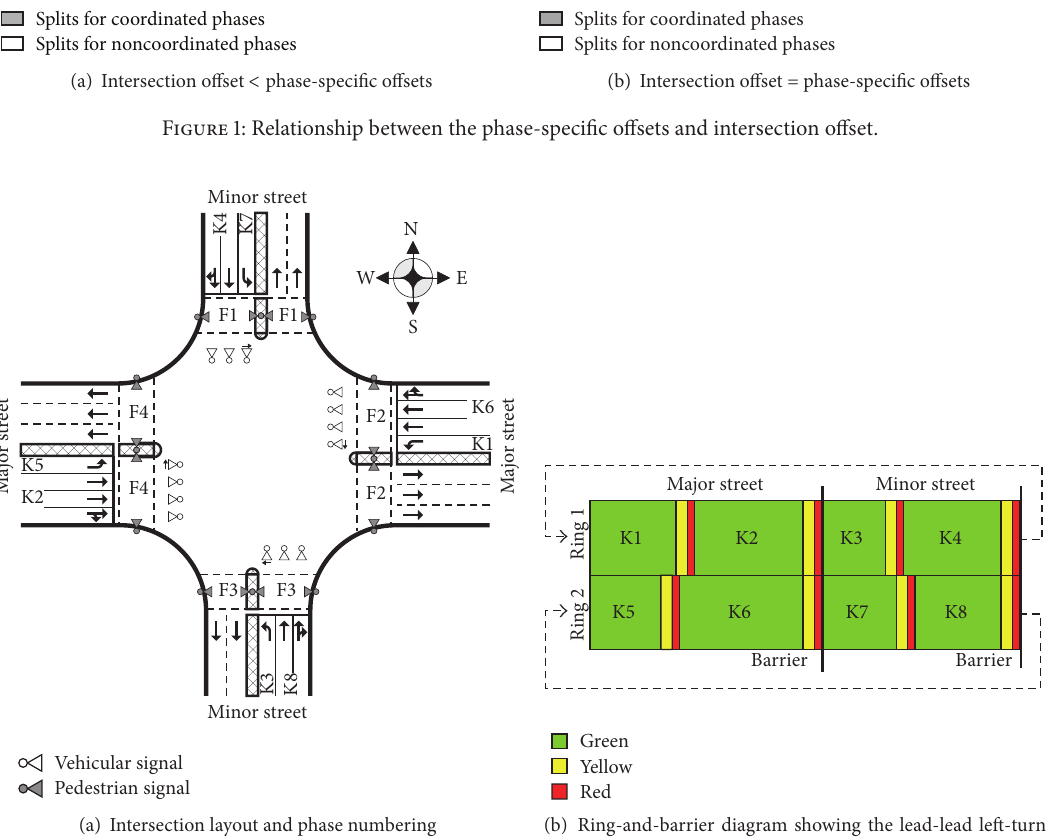
Figure 2: Intersection for presenting the key techniques of